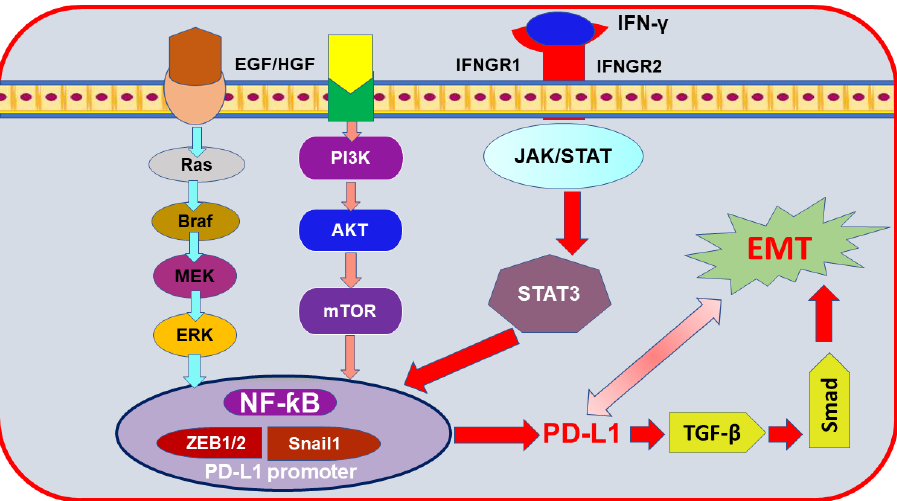
Figure 2. PD-L1-mediated EMT stimulation. The diagram highlights the downstream signaling of EMT in cancer. Interferon-gamma, IFN- γ ; IFN- γ receptor 1/2, IFNGR1/2; epidermal growth factor, EGF; hepatocyte growth factor HGF; Janus kinase, JAK; signal transducer and activator of tran-scription3, STAT3; nuclear factor-kappa B, NF- κ B; phosphoinositide 3-kinase, PI3K; protein kinase B, AKT; mammalian target of rapamycin, mTOR; zinc finger E-box binding homeobox 1/2, Zeb1/2; Snail family transcriptional repressor 1, Snail 1; extracellular-signal-regulated kinase, ERK; mitogen-activated protein kinase, MEK; B-Raf Serine/Threonine-Protein, BRAF; rat sarcoma, Ras; programmed death-ligand 1, PD-L1; transforming growth factor-beta, TGF- β ; mothers against decapentaplegic, Smad; epithelial-mesenchymal transition, EMT.